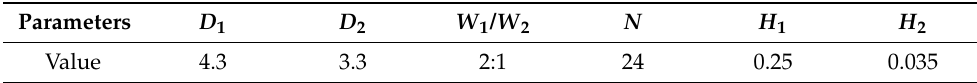
Table 2. Optimized structural dimensions of micro piezoelectric vibrator (mm).